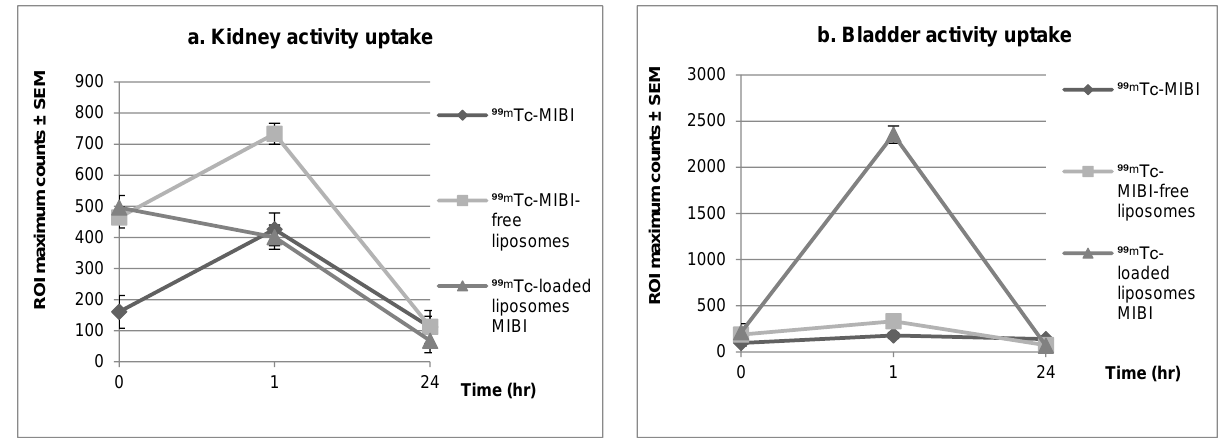
Figure 5. ROI maximum counts ± standard error of mean of ( a ) kidneys and ( b ) bladder for comparison of the clearance of the control 99m Tc-MIBI, 99m Tc-MIBI-free liposomes, and 99m Tc-MIBI-loaded liposomes in blood-pool images immediately after dose administration, as well as 1 h and 24 h post injection.